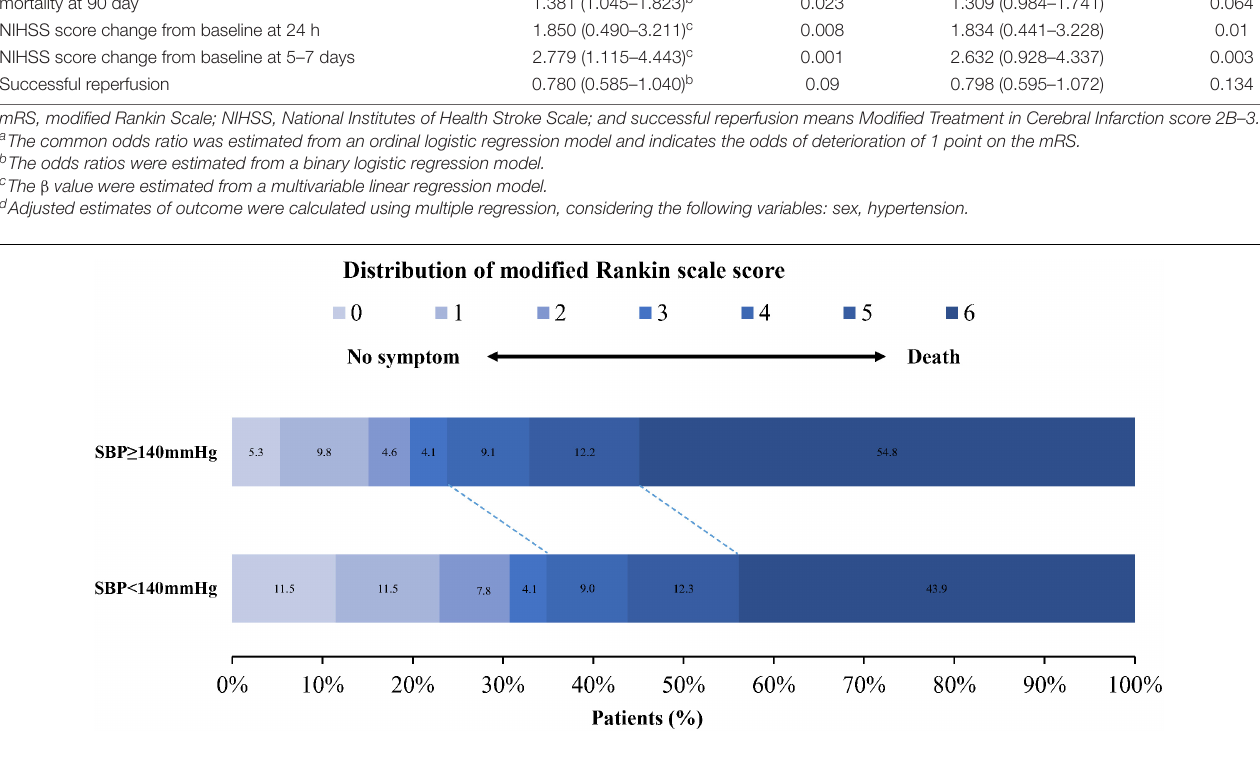
FIGURE 1 | Distribution of the mRS scores at 90 days in patients with acute basilar artery occlusion according to the dichotomized SBP level. SBP, systolic blood